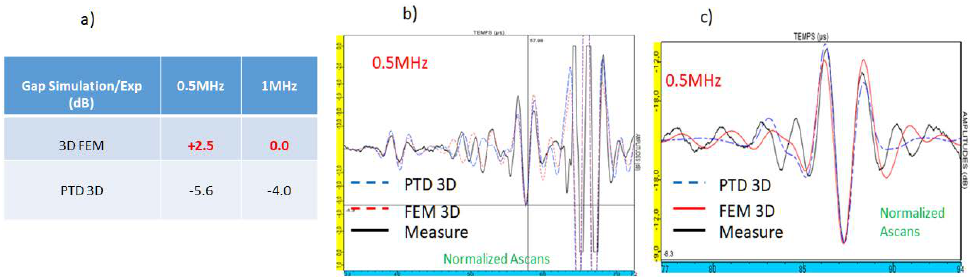
Figure 17. ( a ) Disagreements with measurements obtained with the 3D FEM and PTD simulations; ( b ) Predicted and measured signals with the 0.5 MHz probe; ( c ) the same as ( b ) with normalization on the maximal amplitude.